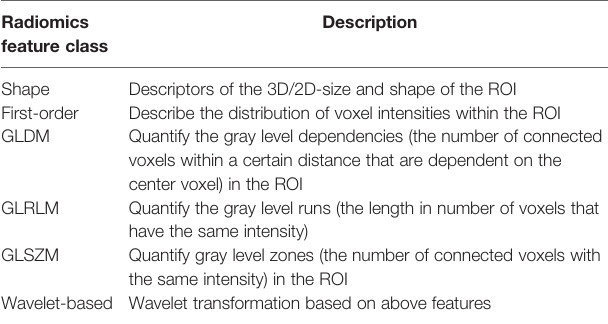
TABLE 1 | List of Radiomics feature